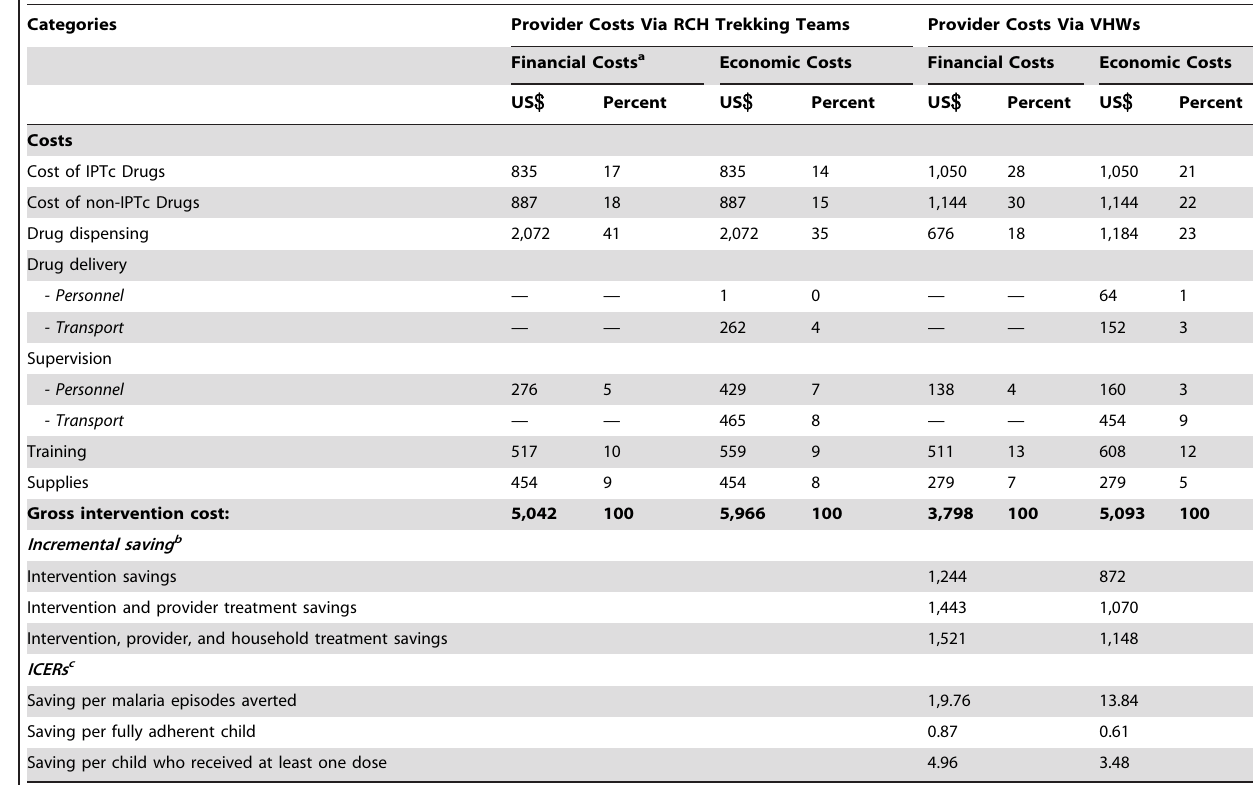
Table 5. Total costs and cost effectiveness by delivery strategy (US $ 2008).